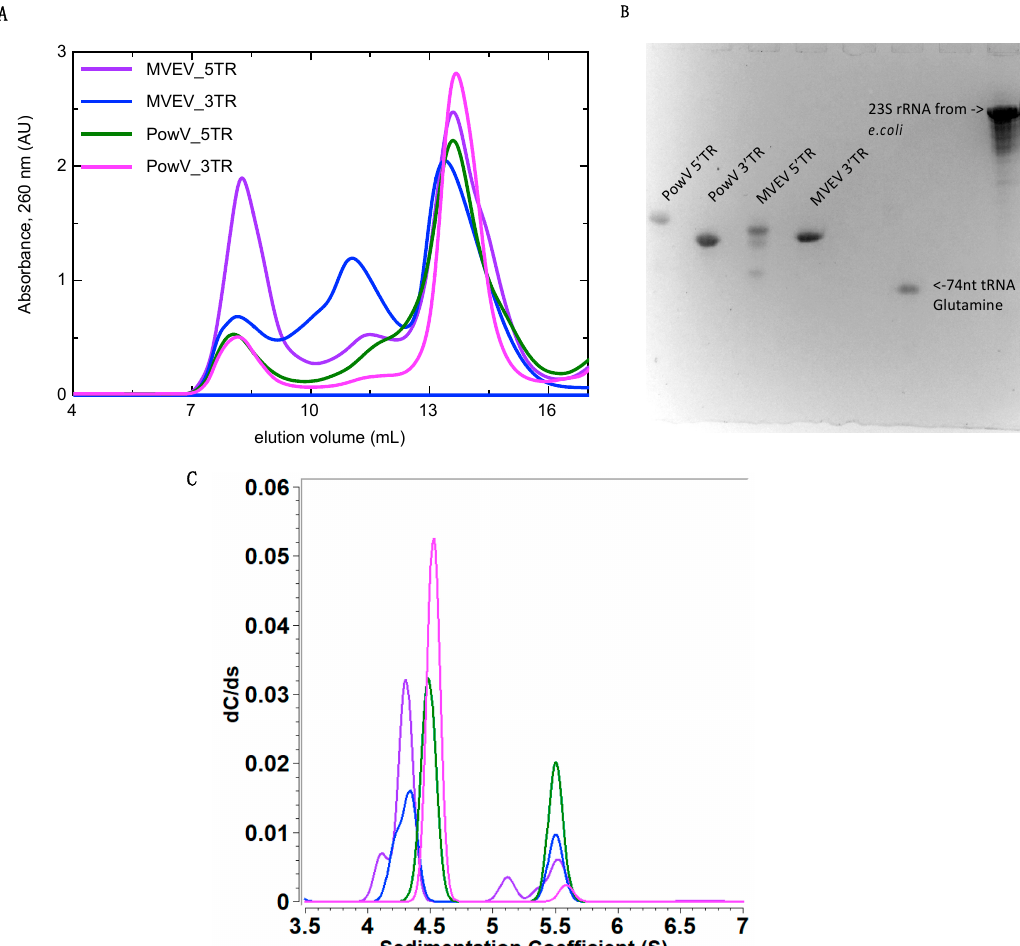
Figure 2. Purification and characterization of in-vitro transcribed 5’ and 3’ terminal regions (TRs) of MVEV and PowV RNA. ( A ) Size exclusion chromatography (SEC) elution profile of purified RNAs where the x-axis represents elution volume and the y-axis represents absorbance at 260 nm; ( B ) Urea-PAGE demonstrating the purity of the individual pooled RNA fractions from SEC peaks (~13 to 14.5 mL). For comparison purposes, we have included 74 nts tRNA and 23S rRNA from Escherichia coli ( C ) Sedimentation coe ffi cient distribution profiles of MVEV and PowV non-coding TRs obtained from sedimentation velocity-analytical ultracentrifugation (SV-AUC). The SV peaks at ~4.5 S for each RNA represent monomeric fractions. The sedimentation coe ffi cient values are corrected to standard solvent conditions (20 ◦ C in